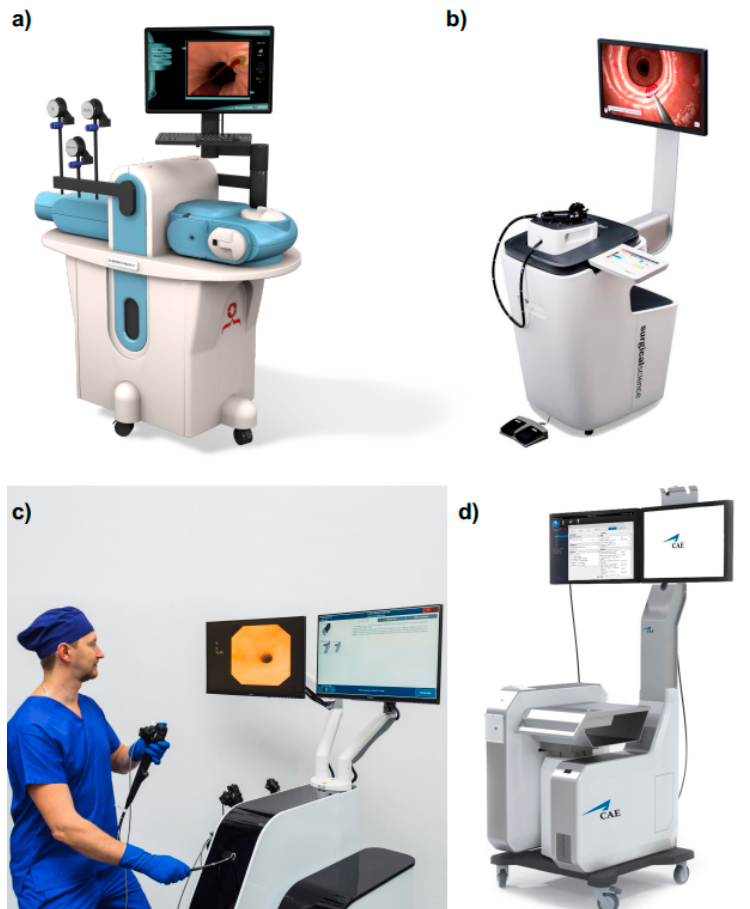
Figure 6. Computerized simulators: ( a ) Simbionix GI Mentor from 3D Systems (Image supplied by 3D Systems); ( b ) EndoSim from Surgical Science (Image supplied by Surgical Science); ( c ) EndoVison system from MedVision (Image supplied by MSE group); ( d ) CAE EndoVR from CAE Healthcare (Image supplied by CAE Healthcare).